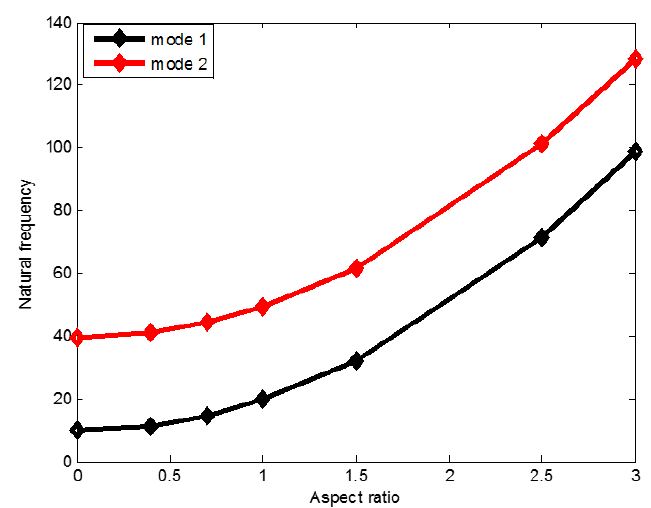
Figure 9. Variation of Aspect ratio on SF edge condition